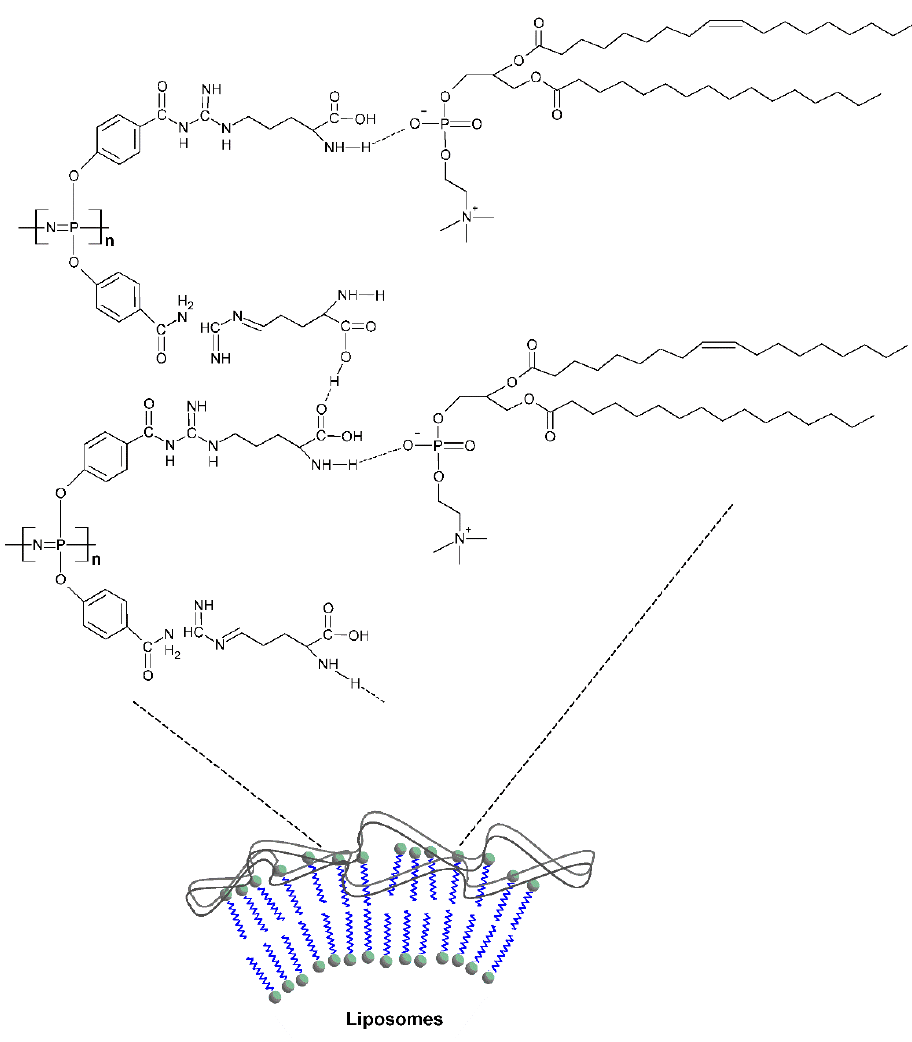
Figure 18. The polyphosphazene–arginine–layered liposome.